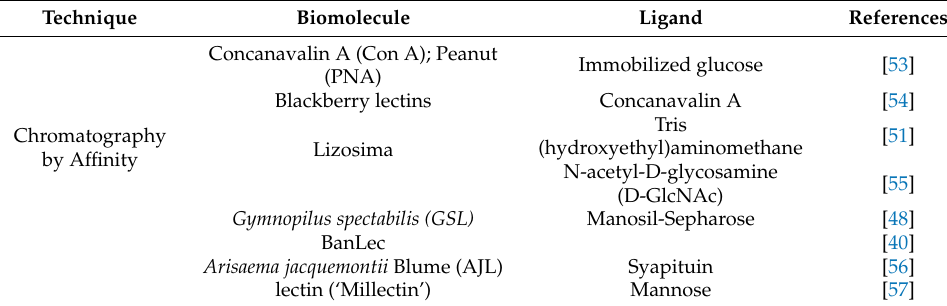
Table 3. Main binders in affinity